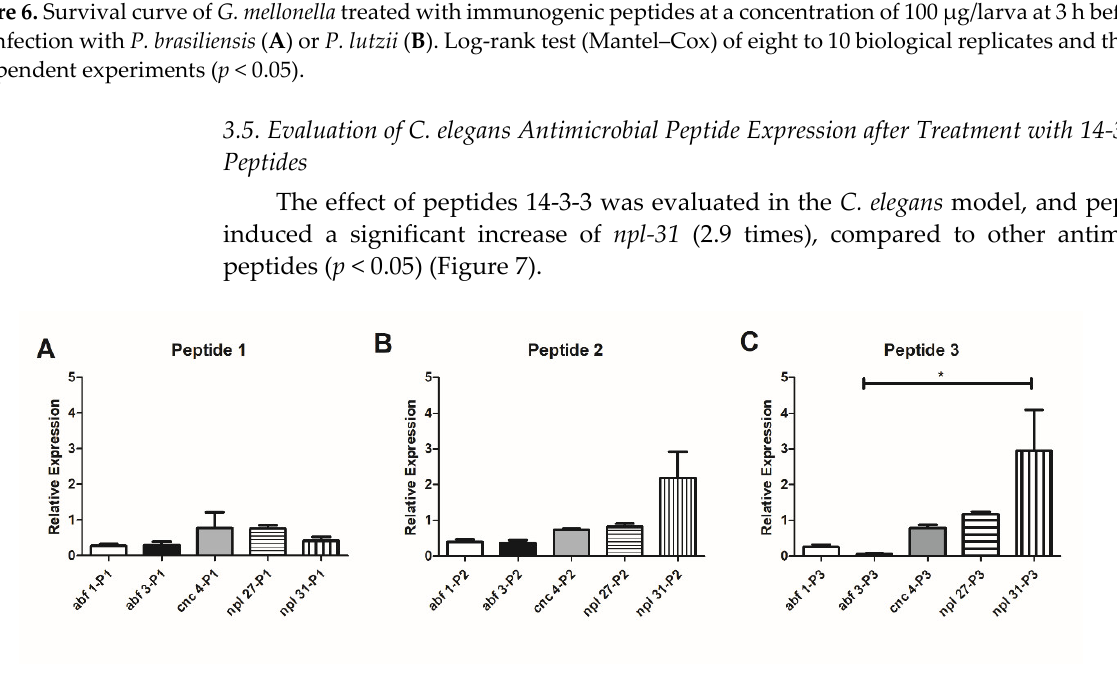
Figure 7. Relative expression of abf-1 , abf-3 cnc-4 , npl- 27 and npl-31 genes related to the production of C. elegans antimicrobial peptides when in contact with P1 ( A ), P2 (B ) or P3 ( C ). Data are expressed as mean ± standard deviation of three biological replicates and three independent experiments (* p < 0.05) using Kruskal–Wallis and